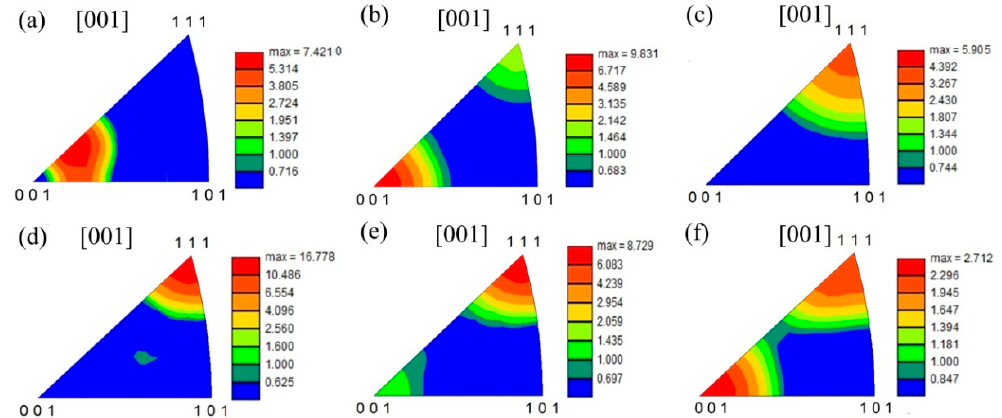
Figure 8. B 2 phase IPF of the as-rolled and can-compressed Ti 2 AlNb samples subject to annealing treatment: ( a ) as-rolled, ( b ) 25%, ( c ) 50%, ( d ) 60%, ( e ) 65%, and ( f )